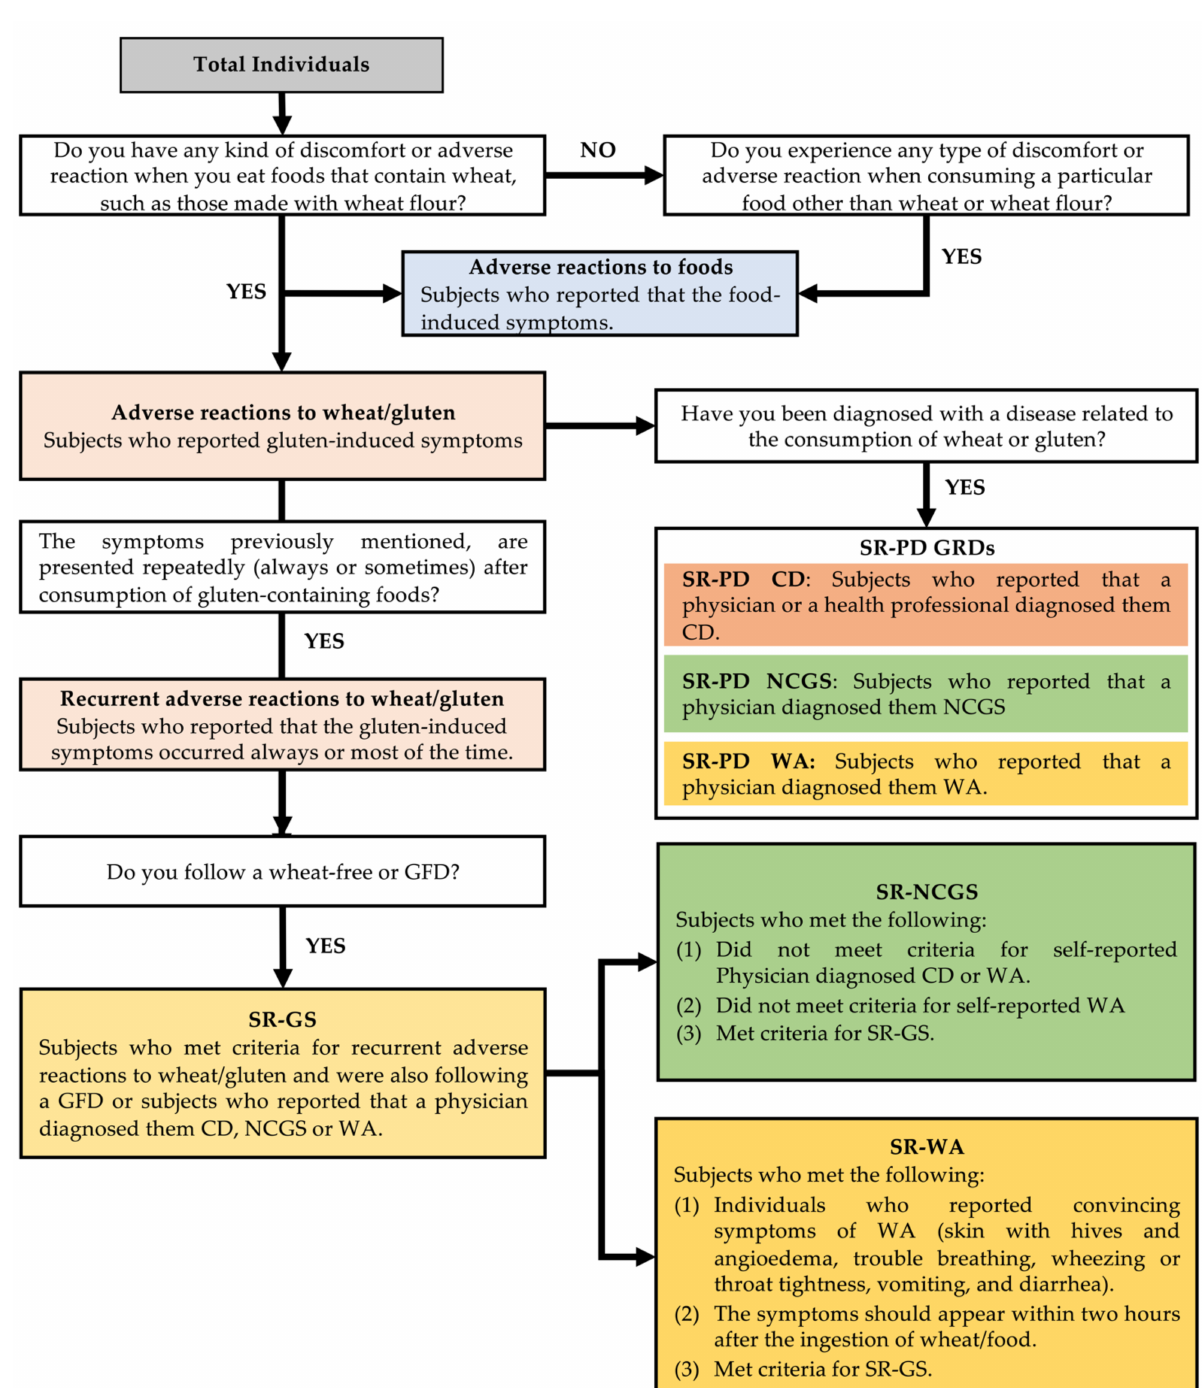
Figure 1. Algorithm and criteria to classify respondents. SR-GS—self-reported gluten-sensitivity; GFD—gluten-free diet; SR-PD—self-reported physician-diagnosed; GRDs—gluten-related disorders; CD—celiac disease; NCGS—non-celiac gluten-sensitivity; WA—wheat